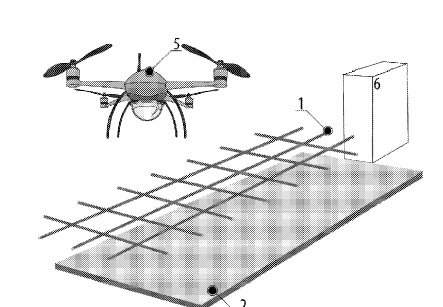
Figure 6. Method of recharging the batteries of unmanned aerial vehicles [36] as an example of a landing station without positioning with vertical electrodes separation. 1, electrode in the form of a metal grid; 2, electrode in the form of a metal sheet; 5, UAV; 6, charging controller.